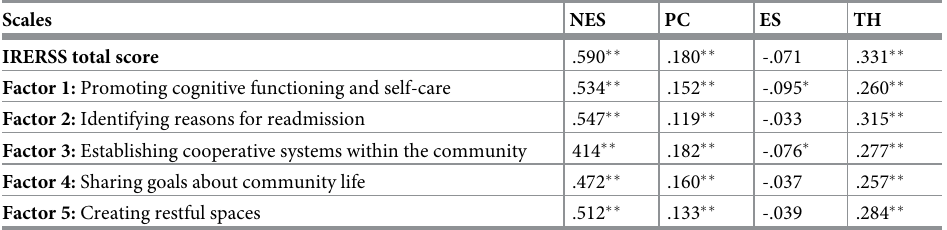
Table 3. Correlation between the overall scale and each subscale score on the IRERSS, each subscale score of the EssenCES-JPN, and the overall score on the NES (n = 724). Scales NES PC ES TH IRERSS total score .590 �� .180 �� -.071 .331 �� Factor 1: Promoting cognitive functioning and self-care .534 �� .152 �� -.095 � .260 �� Factor 2: Identifying reasons for readmission .547 �� .119 �� -.033 .315 �� Factor 3: Establishing cooperative systems within the community 414 �� .182 �� -.076 � .277 �� Factor 4: Sharing goals about community life .472 �� .160 �� -.037 .257 �� Factor 5: Creating restful spaces .512 �� .133 �� -.039 .284 �� Abbreviations: IRERSS = In-hospital nursing care leading to reduction in early readmission among patients with schizophrenia scale, NES = Nursing excellence scale in clinical practice, PC = Patients’ cohesion and mutual support, ES = Experienced safety, TH = Therapeutic hold.